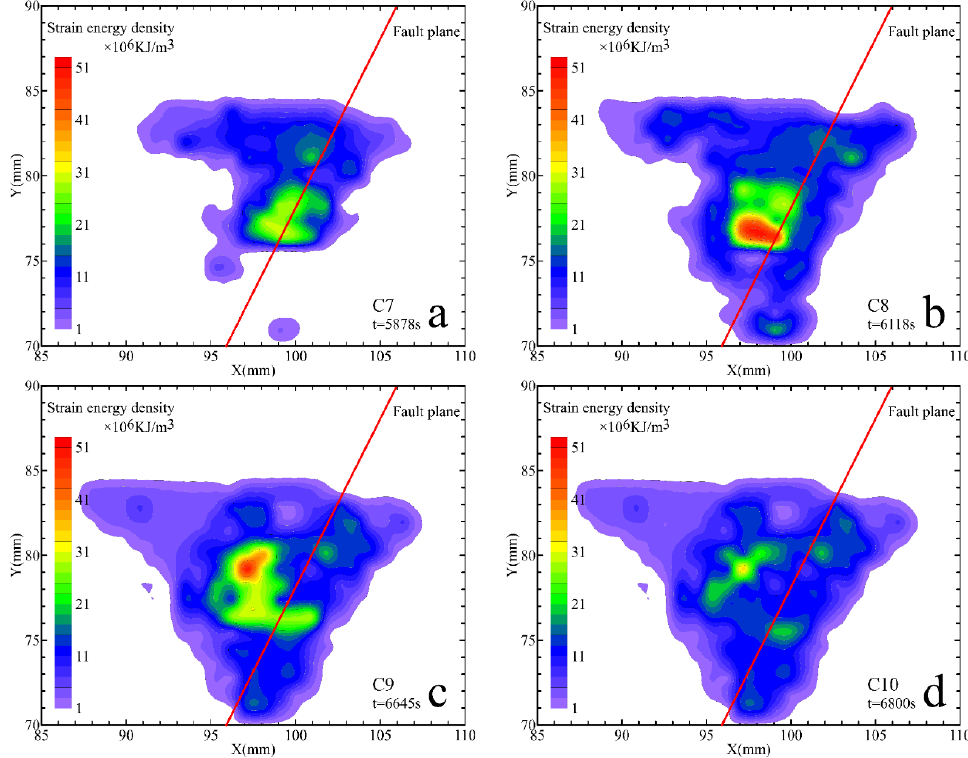
Figure 14. Strain energy density distribution at ( a ) C7, t = 5878 s; ( b ) C8, t = 6118 s; ( c ) C9, t = 6645 s; and, ( d ) C10, t = 6800 s. Strain energy bullseye at the top left is the “incubation stage” of the antithetic fault.